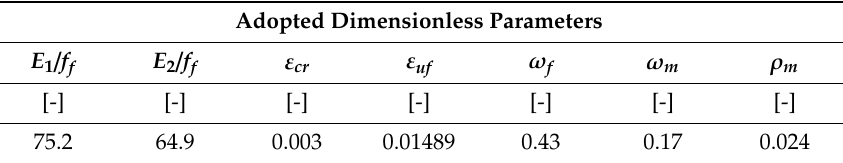
Table 4. Dimensionless parameters, adapted from Papanicolaou et al.